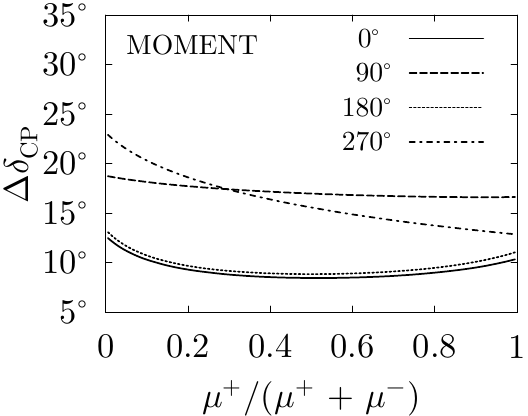
Figure 5. The e(cid:11)ect of beam polarity on the precision measurement of (cid:14) CP . The 1 (cid:27) con(cid:12)dence level uncertainties for (cid:14) CP are shown as a function of the fraction at which MOMENT operates